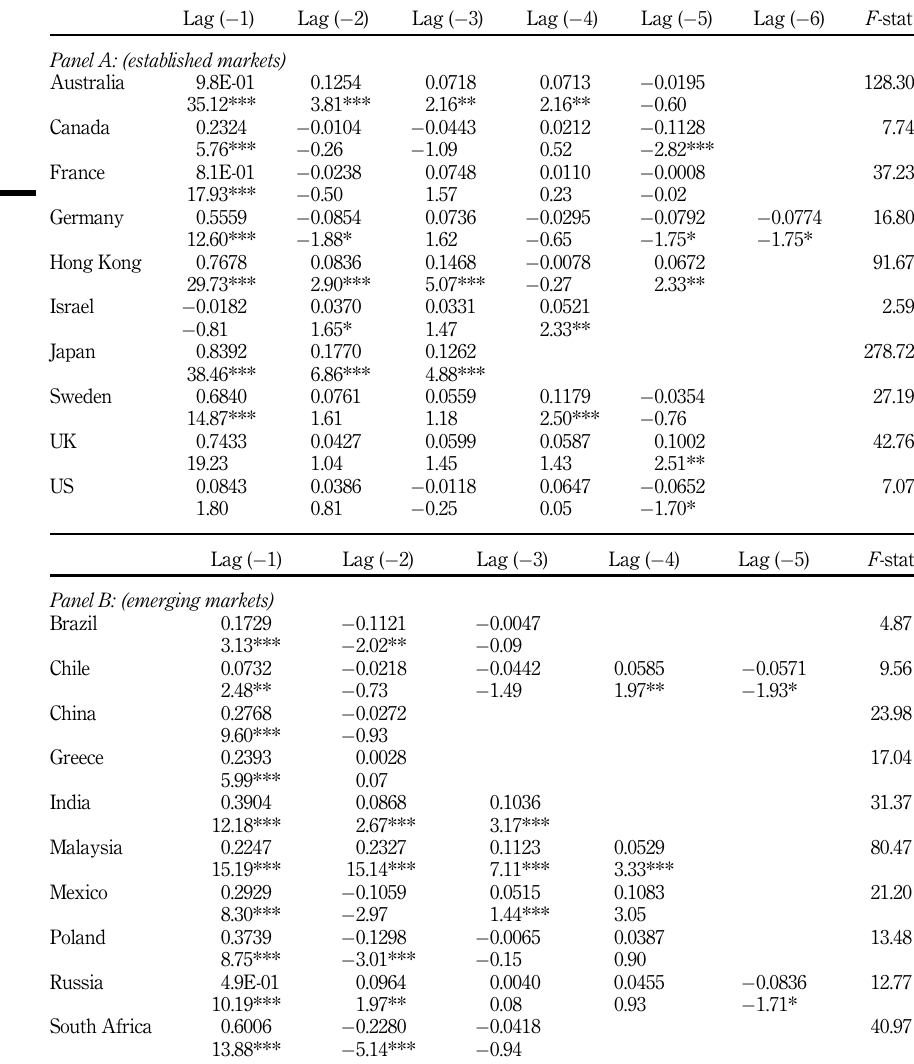
Table 5. Coefficients and t -ratios for world-index lags in VAR